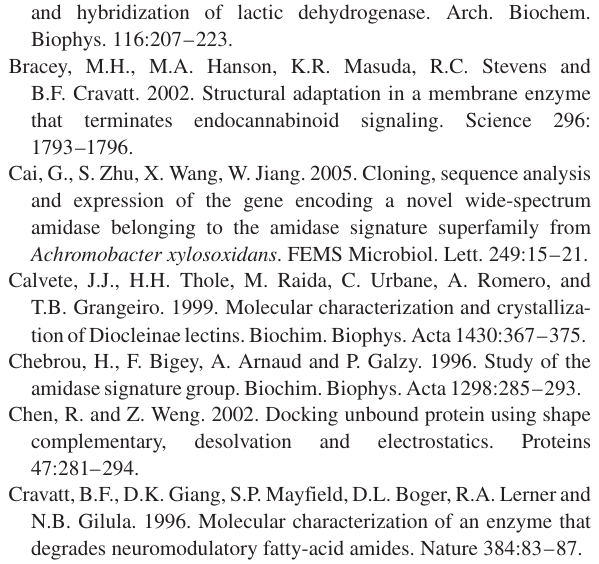
Figure 5. Model of the Sulfolobus solfataricus recombi- nant WT amidase dimer, illustrat- ing the mechanism of pH-, temperature- and ion-dependent oligomerization. In panel A, the residues of the dimer subjected to mutation are in blue (T319), in light red (D487), in magenta (L34), or in green (Y41). The amino- and carboxy-terminal resi- dues of the protein are shown as blue and red spheres, respectively. The catalytic triad at the active site K96 (orange), S171 (yellow) and S195 (dark green) is also shown. Panel B provides a repre- sentation of the octamer: each cyl- inder represents a dimer. Tyrosine 41 residues are indicated by green triangles; hydrophobic patches on contiguous dimers are indicated in light yellow